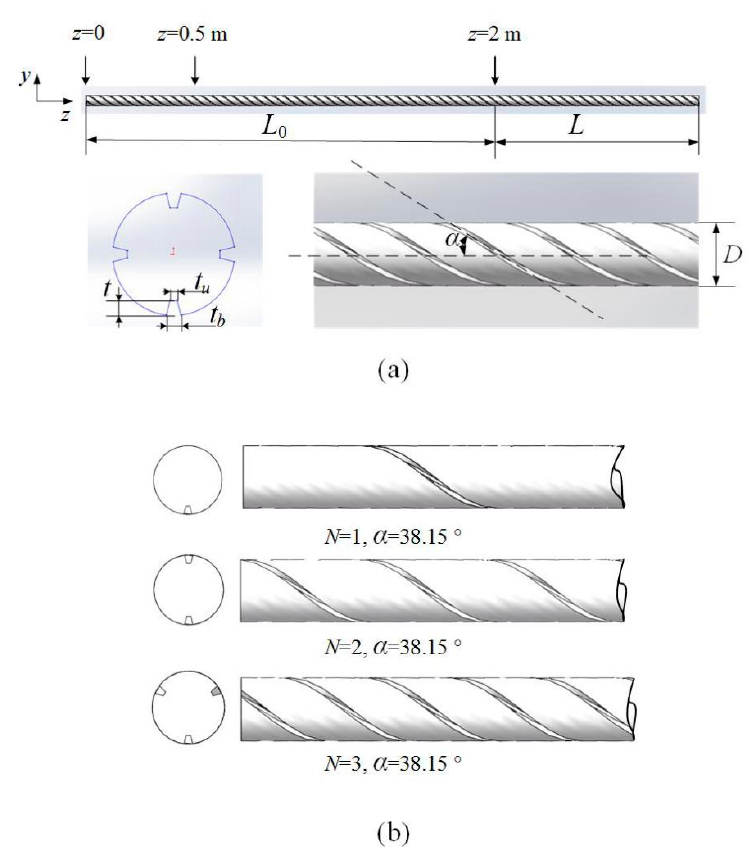
Figure 1. ( a ) Geometry of PBRs and spiral ribs; ( b ) tubular PBRs with 1, 2 and 3 ribs and an inclined angle α = 38.15.